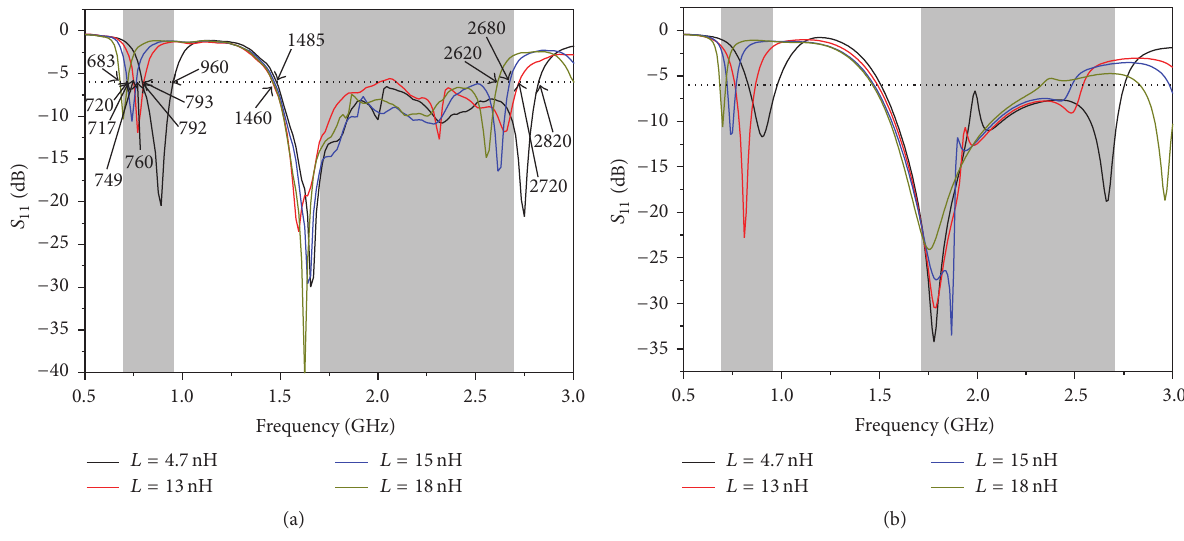
Figure 8: Measured (a) and simulated (b) reflection coefficients for the proposed antenna against